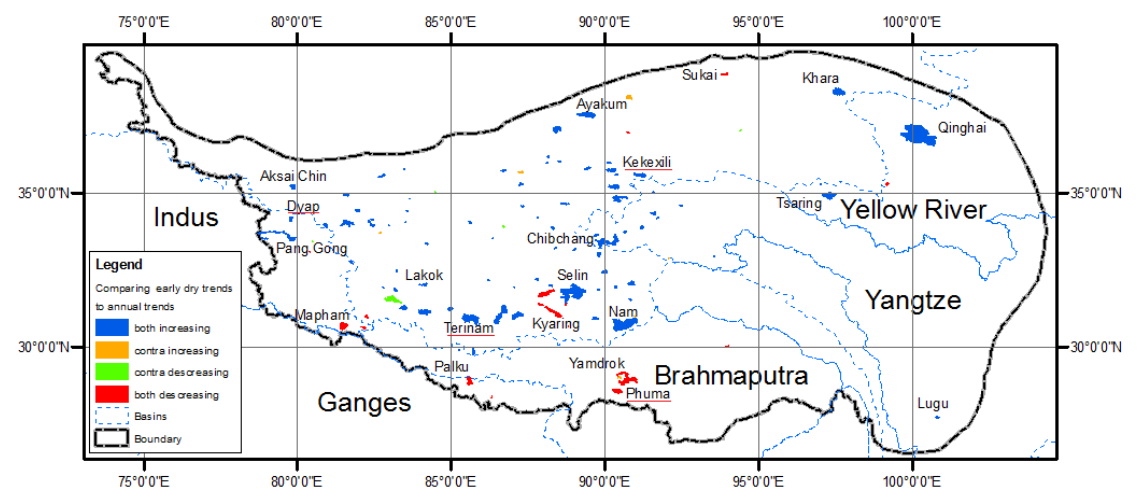
Figure 3b. Comparing early dry to annual water level trends of the Tibetan lakes between 2003 and 2009